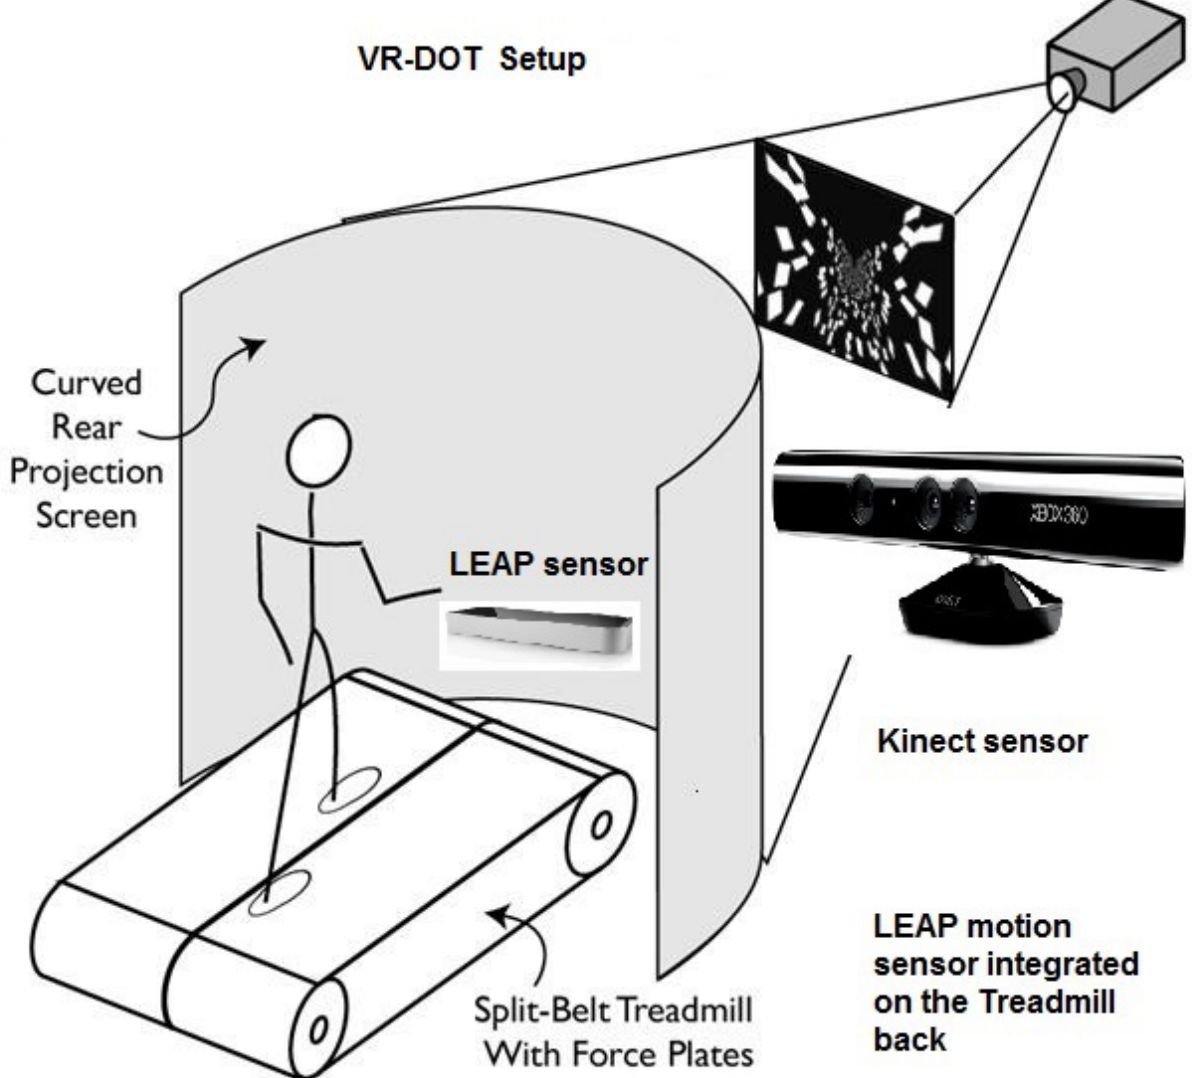
Figure 1. Virtual reality day-out task (VR-DOT) participant